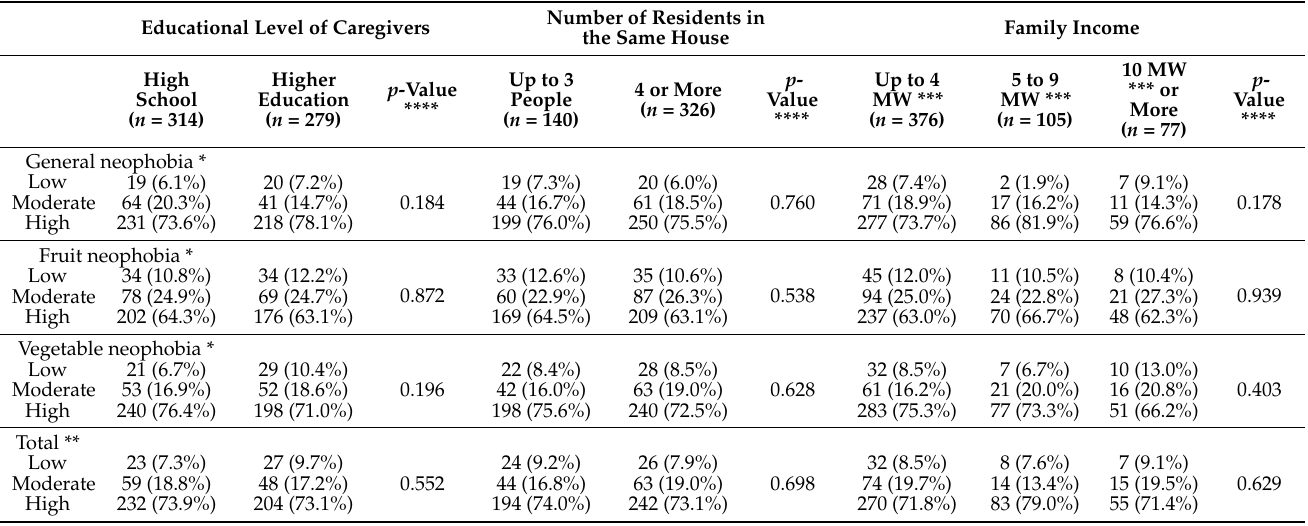
Table 3. Distribution of the food neophobia classification by the educational level of caregivers, the number of residents in the same house, and family income (Brazil,